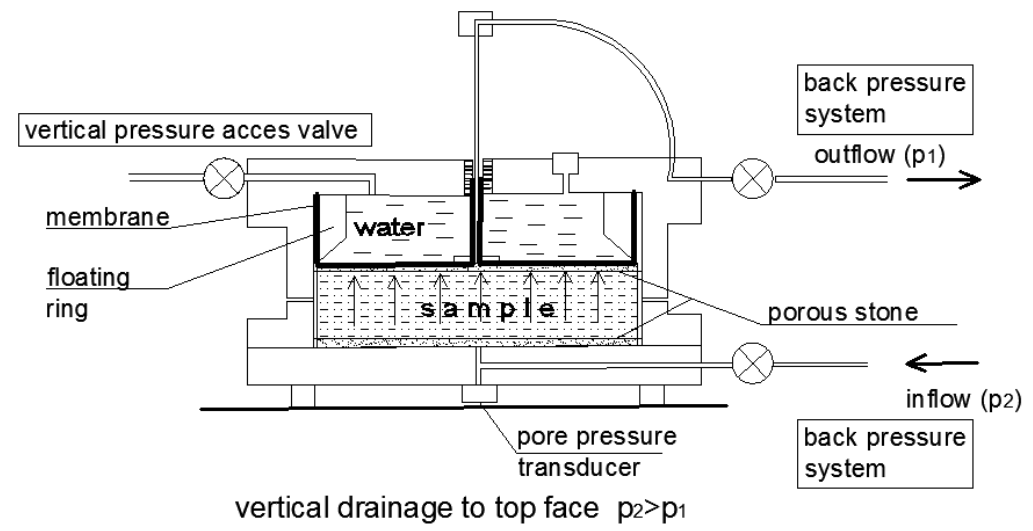
Figure 6. The Rowe-Barden consolidation cell set up for hydraulic conductivity test with vertical drainage to the top face.